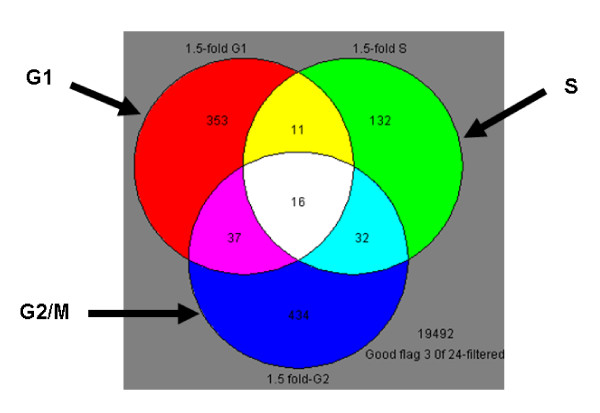
Venn diagram of the gene lists in different phases. Only genes that exhibited 1.5-fold or greater change after BaP treatment are shown. The gene lists represent expression profiles of MCF-7 cells synchronised in different phases of the cell cycle. Although there was overlap of the expression profiles between the phases, the majority of the changes were cell-cycle dependent.